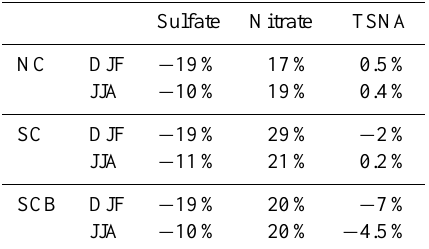
Table 2. The percentage change of sulfate, nitrate and TSNA mass concentrations from 2006C to 2015C (2015C minus 2006C), aver- aged for summer (June, July, August; JJA) and winter (December, January, February, DJF). Sulfate Nitrate